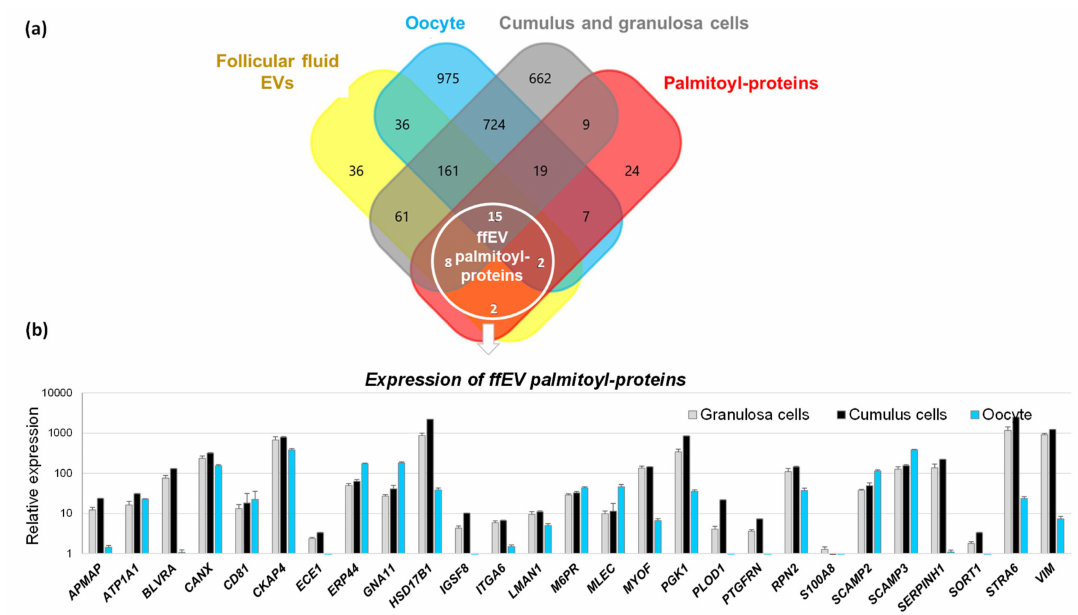
Figure 2. Analyses of palmitoylated proteins identified from bovine follicle. ( a ) Comparison of bovine proteomes of follicular fluid extracellular vesicles, GC [45], cumulus cells [52], and oocytes [53] with the list of palmitoylated proteins here identified from ovarian follicular cells. The 27 proteins shared with follicular fluid EV proteome are encircled. ( b ) Gene expression patterns of 27 palmitoyl-proteins detected in follicular fluid EVs by transcriptome analysis (GSE149151). Bars are mean values of 4 independent replicates ±